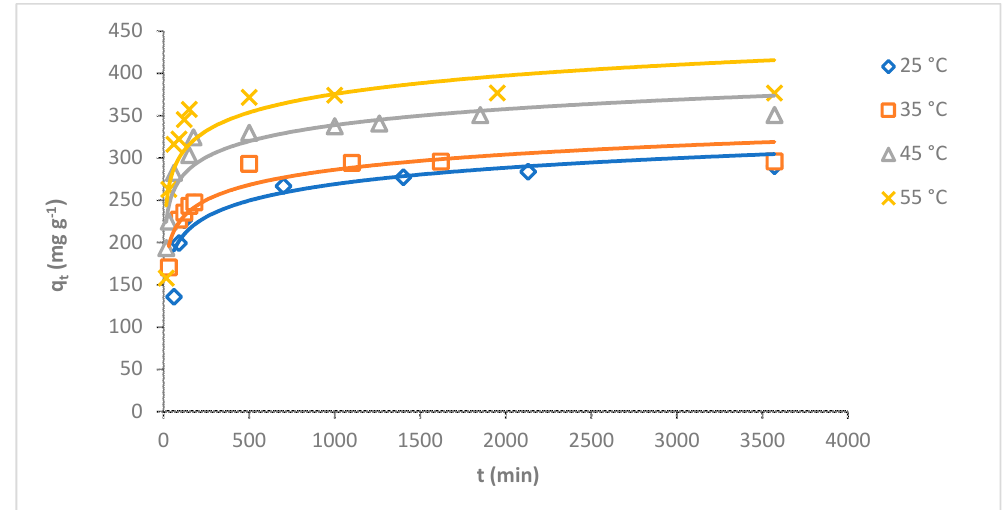
Figure 6. Effect of temperature on adsorption of MB dye onto O -CM-chitosan hydrogel at different time intervals (adsorbent mass 0.05 g, dye solution (50 mL, 1000 mg L − 1 ) and pH 7).